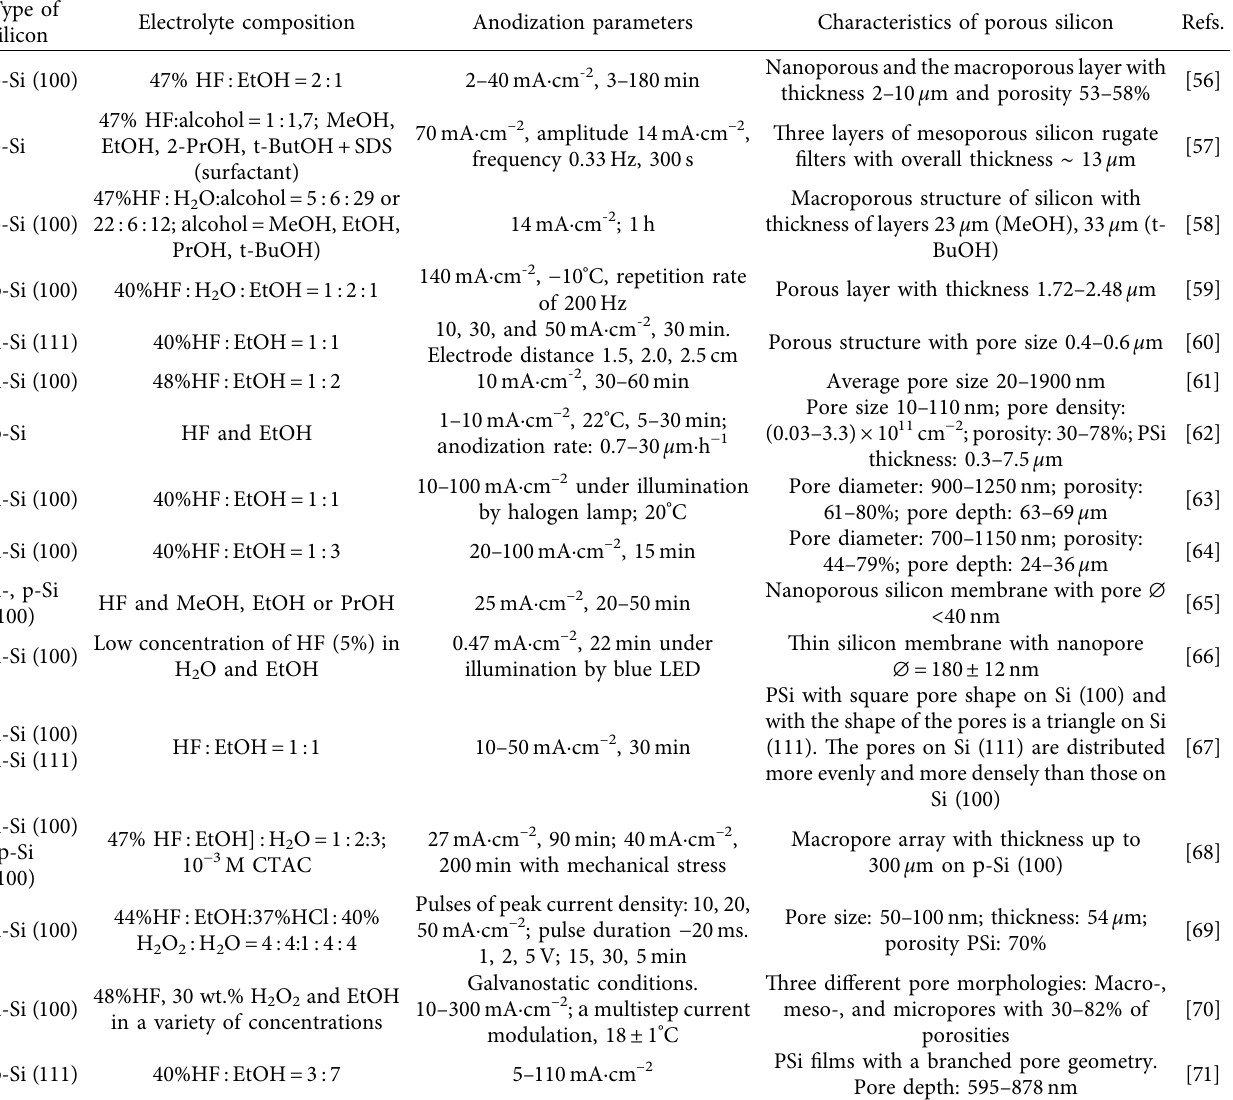
Table 1: S onditions for the formation of porous silicon by electrochemical